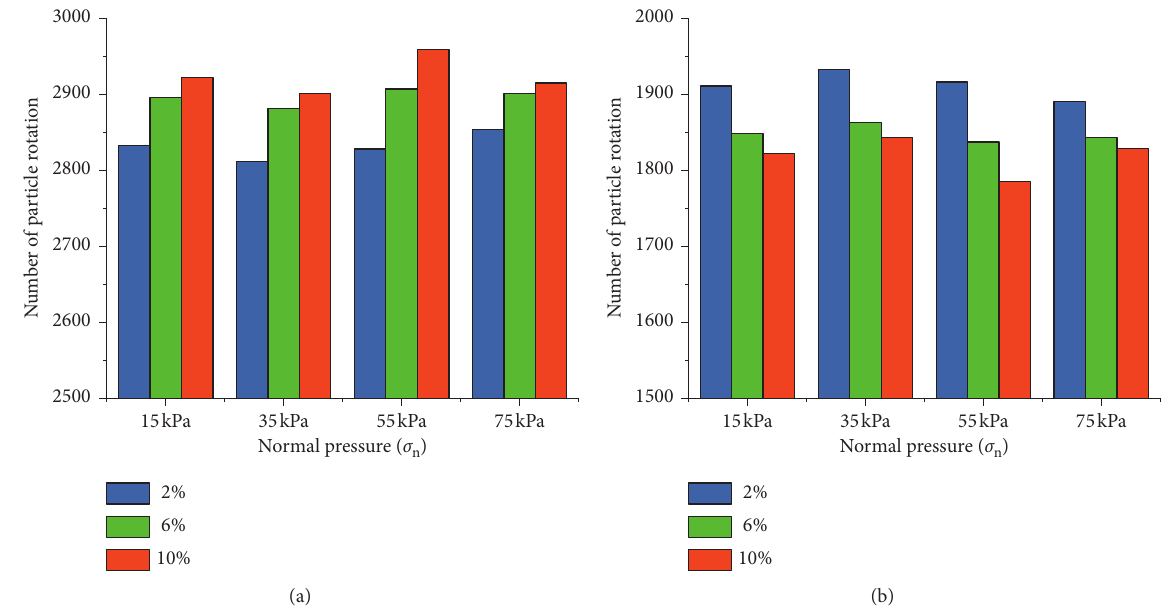
Figure 11: The total number of particle rotations at ε s of 2%, 6%, and 10%: (a) about the negative y -axis; (b) about the positive y